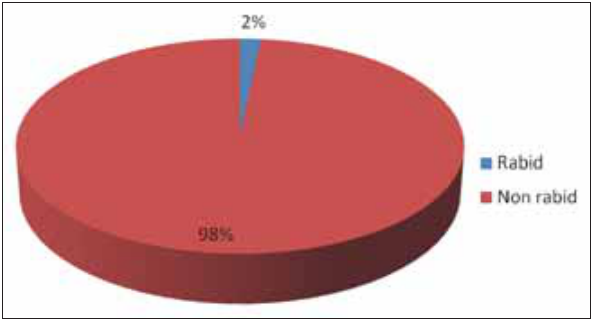
Figure-1: Rabies status of the dog presented to the Veterinary Teaching Hospital Zaria between 2002 and 2011.